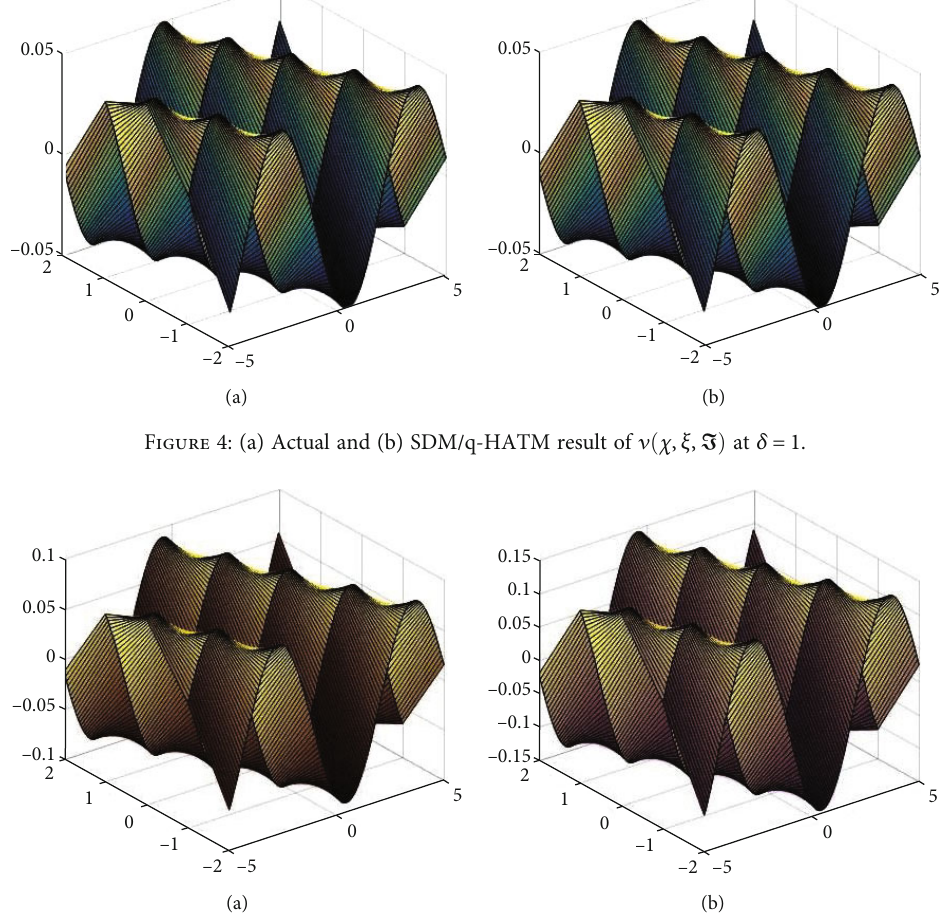
Figure 5: The di ff erent fractional-order result of ν ð χ , ξ , I Þ at δ = (a) 0 : 8 and (b) 0 : 6 of example.